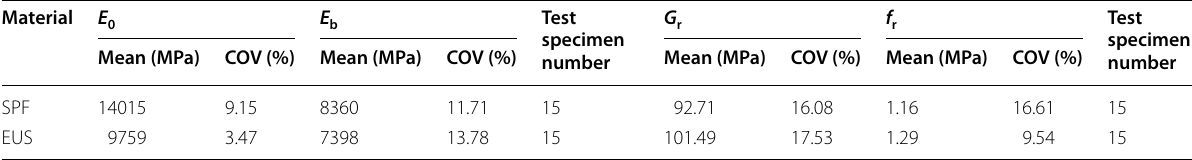
Table 1 The properties of materials and rolling shear